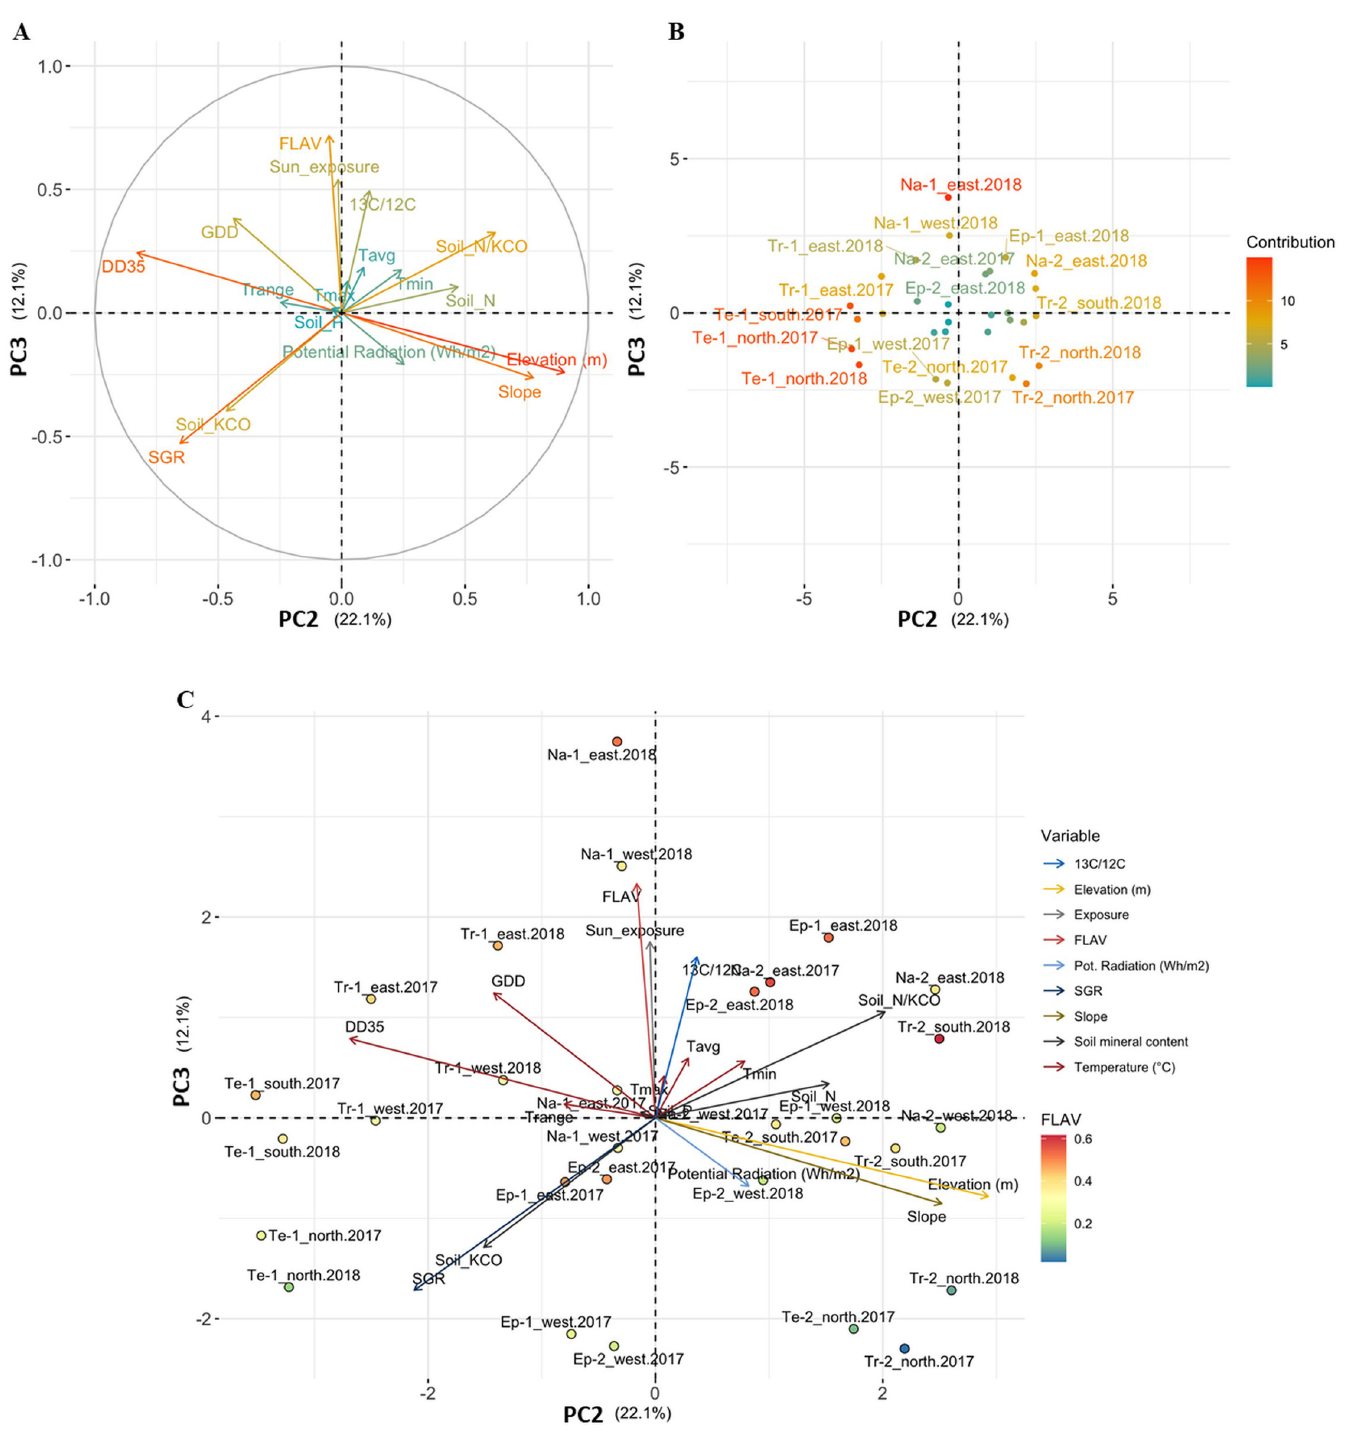
Fig 5. PCA of PC2-PC3 of agro-climatic variables and grape bunch flavonol content, FLAV. Loading plot (A) and scores plot (B) on PC2 and PC3 showing the contribution of variables and individuals, respectively, to each PC, and C) shows the biplot that overlays loadings plot and scores plot on PC2 and PC3. Individual points (coloured by FLAV content averaged on three replicates) represent the observations; variables (arrows) are coloured according to different categories [elevation, temperature parameters and indices, e . g ., GDD and DD35, stable carbon isotopic fraction, slope, and mineral soil content (N, P, and KCO)].